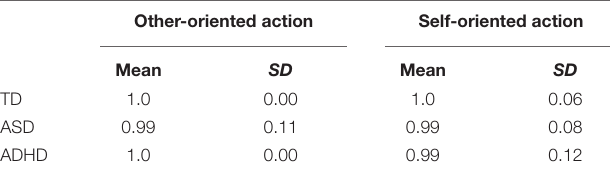
TABLE 8 | Mean proportions correct responses in the production